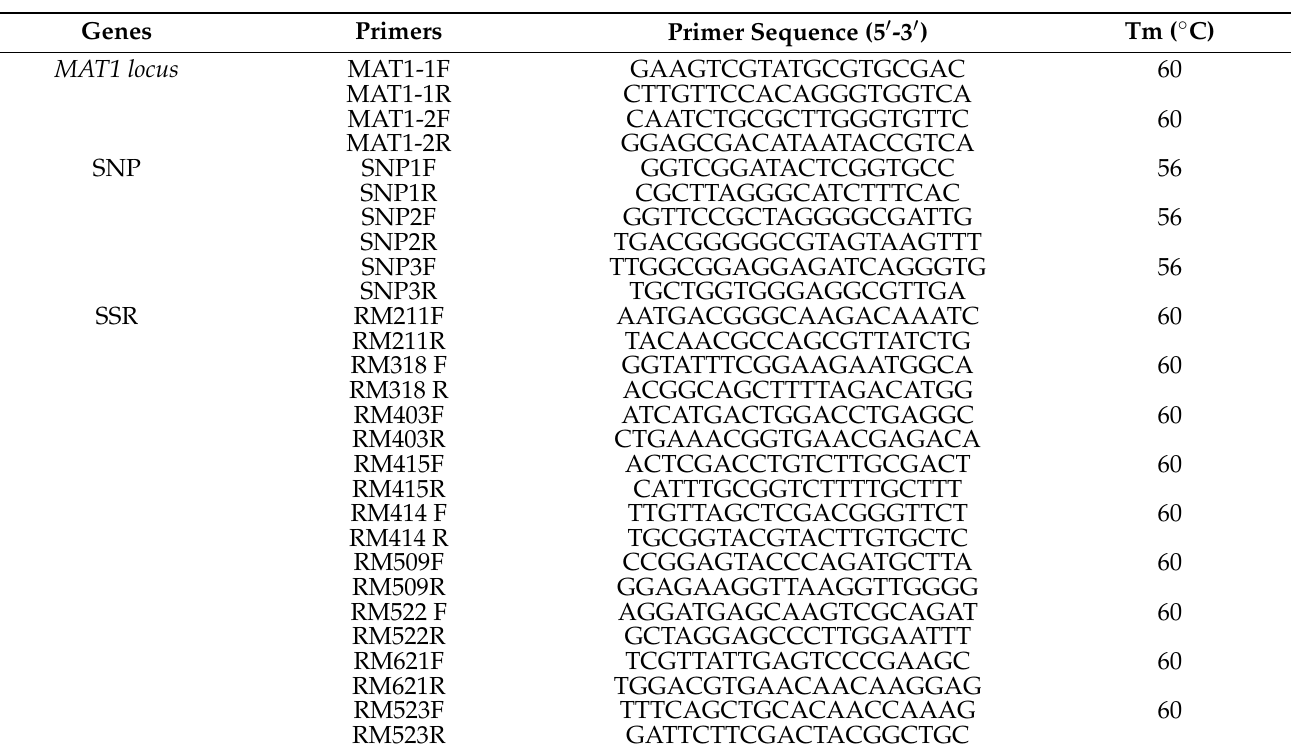
Table 2. Different primers used in the present